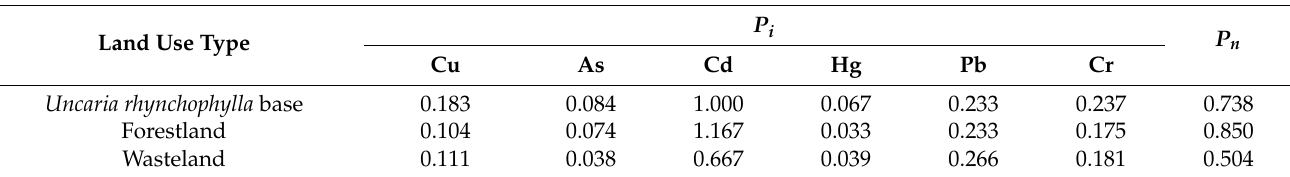
Table 5. Heavy metal pollution